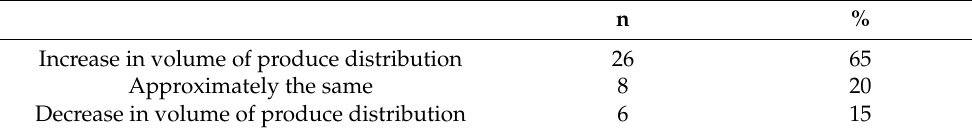
Table 9. Overall Produce Amount Distributed in 2020 Compared to 2019.